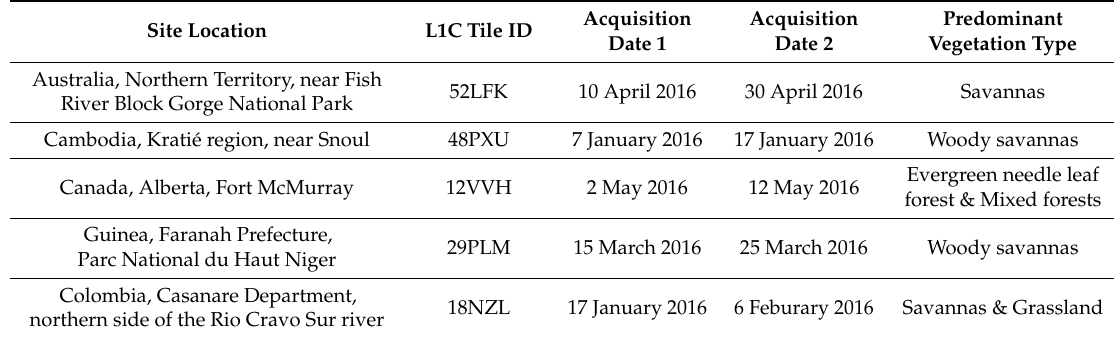
Table 1. Sentinel-2A Multi Spectral Instrument (MSI) L1C tile data